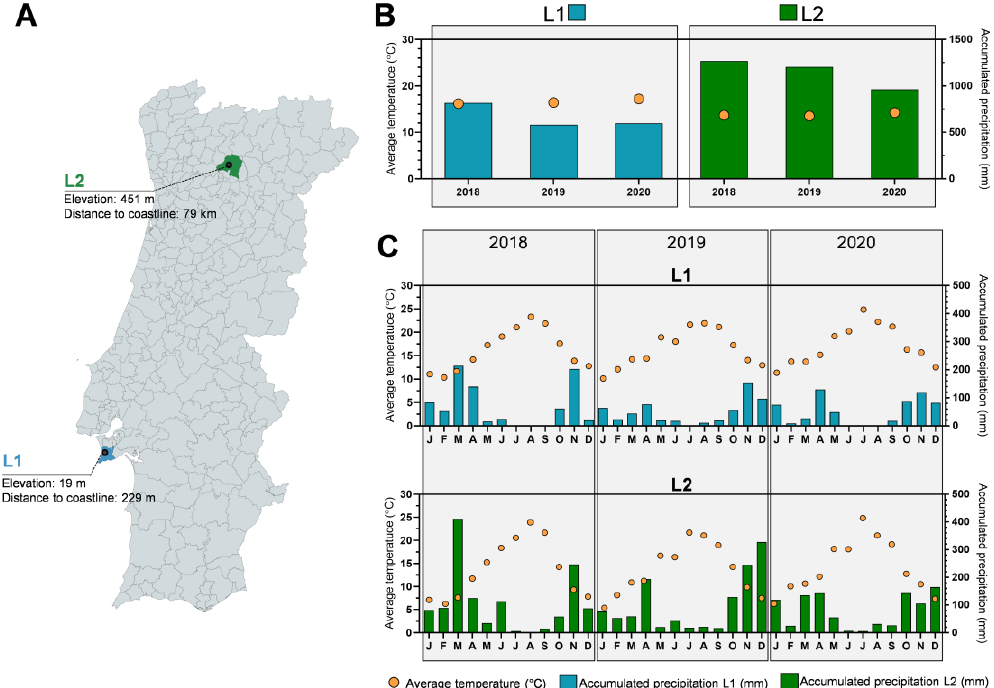
Figure 1. Identification of harvesting locations and climatic conditions in which the Thymus carnosus used in this work grew. Geographic location of T. carnosus harvest points, elevation from sea level and distance to coastline, nearest location in straight-line distance ( A ), and annual ( B ) and mensal ( C ) variation of average temperature (in °C; yellow dots) and accumulated precipitation for 2018–2020 period in L1 (blue bars) and L2 (green bars).